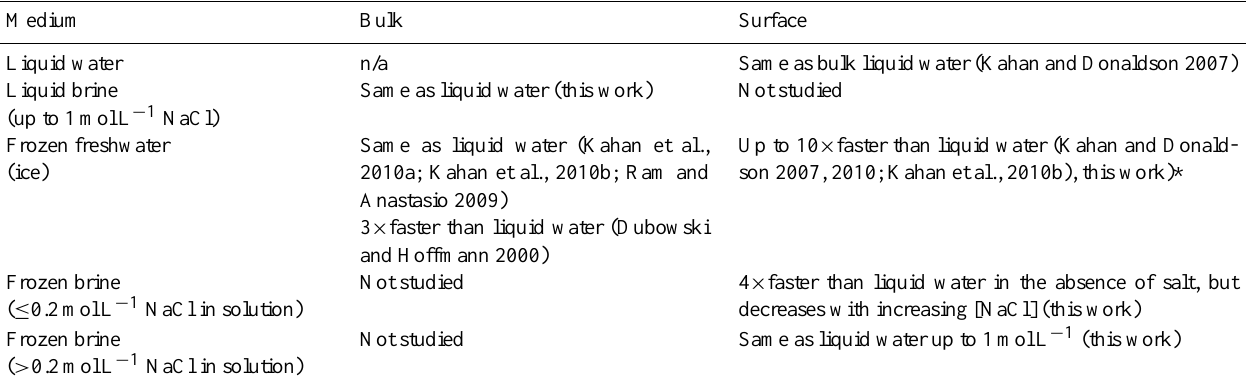
Table 1. Predicted photochemical behaviour of aromatic compounds in and at the surface of liquid and frozen aqueous media, relative to those in bulk liquid water